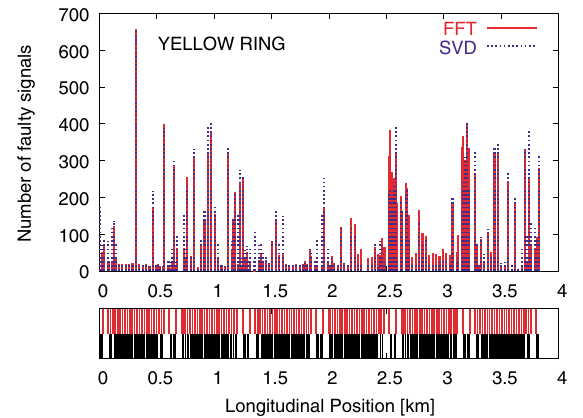
FIG. 12. (Color) Comparison of the FFT and SVD techniques for 678 files from the yellow ring showing a good agreement. The number of times a BPM provides a faulty signal is plotted versus its